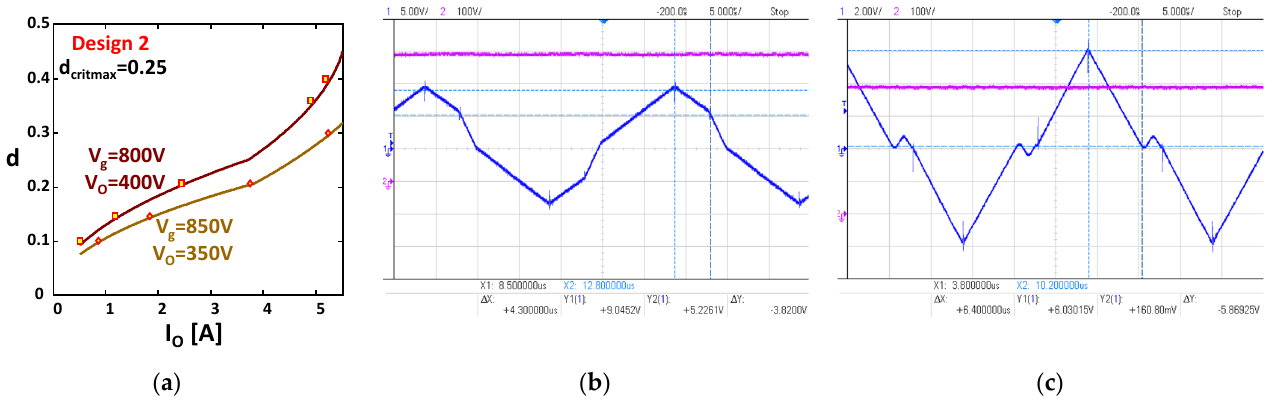
Figure 11. Experimental results using Design 2 ( d critmax = 0.25, n = 1, and L = 407 uH), V g = 800 V and V O = 400 V. ( a ) Experimentally measured output current for different duty cycles. Inductor current (blue) and output voltage (violet) in ( b ) CCM at 2 kW (d = 0.36) and ( c ) DCM at 1 kW (d = 0.206).